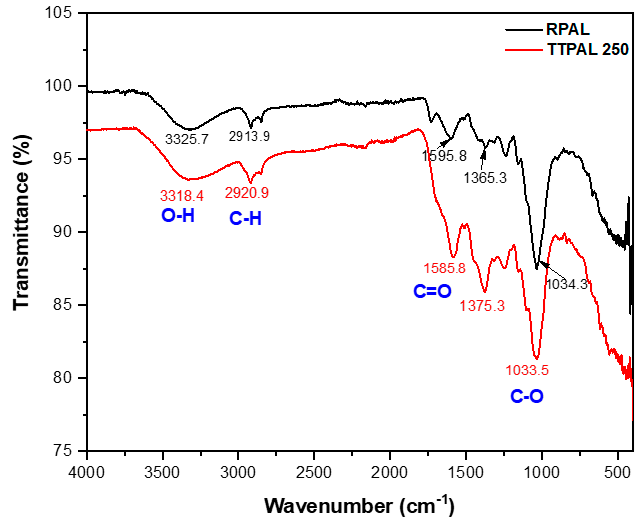
Figure 5. FT-IR spectra of RPAL and Figure 5. FT − IR spectra of RPAL and TTPAL250.